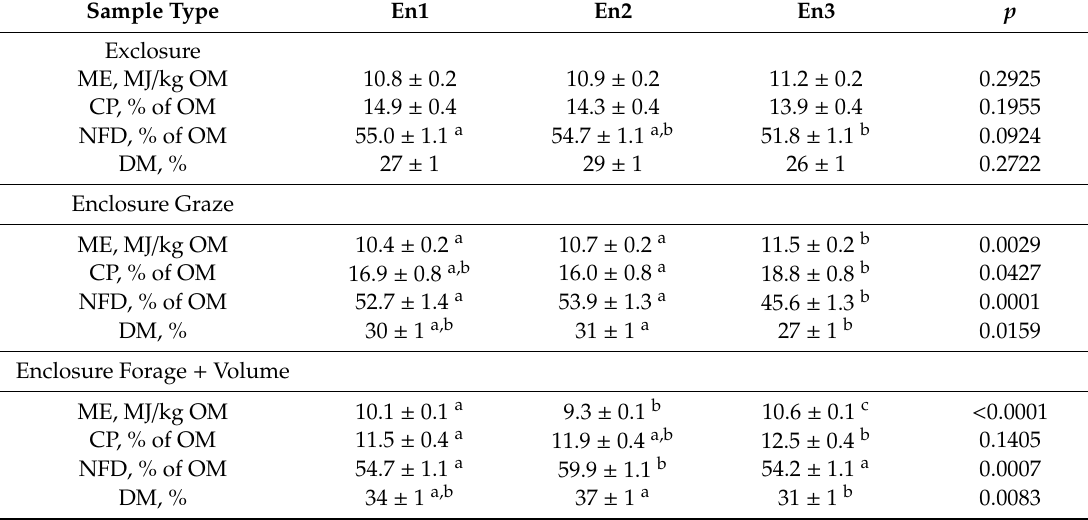
Table 5. Content of dry matter (DM), metabolizable energy (ME) per kg organic matter (OM), crude protein (CP) as % of OM, and neutral detergent fiber (NDF) content as % of OM in four types of pasture samples collected in three enclosures (En1–En3) grazed all year round by Gotlandsruss and in